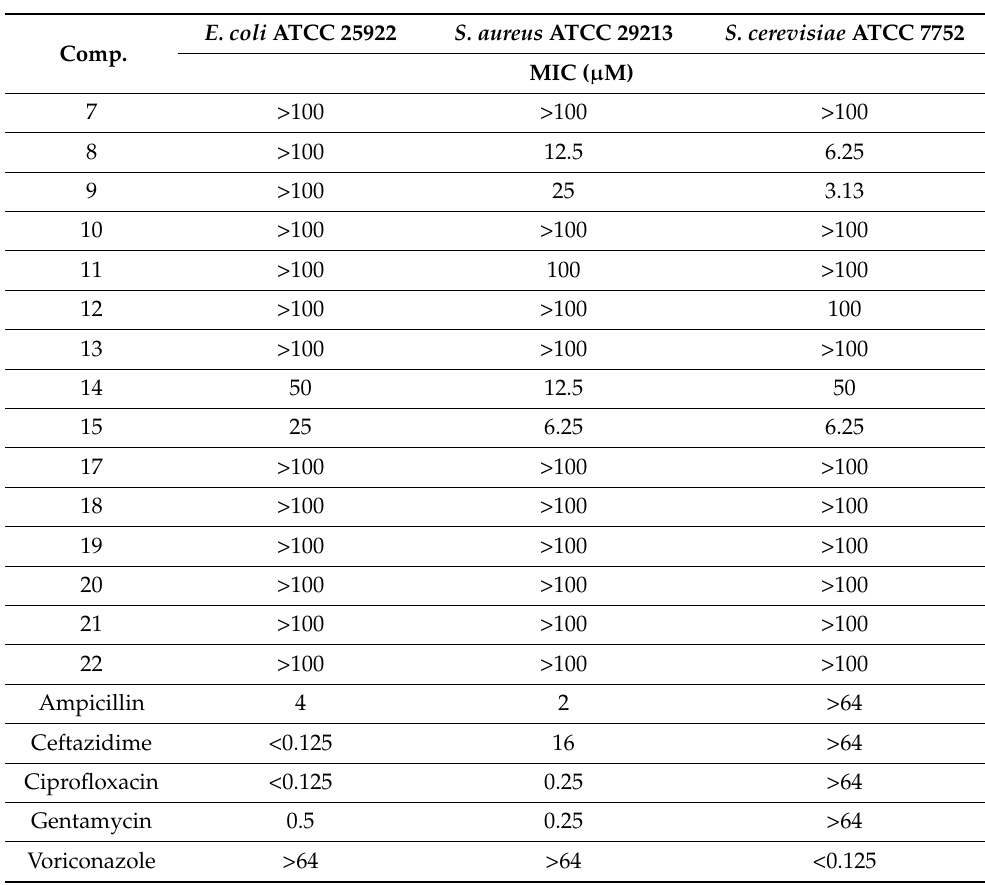
Table 3. Cont. Comp.